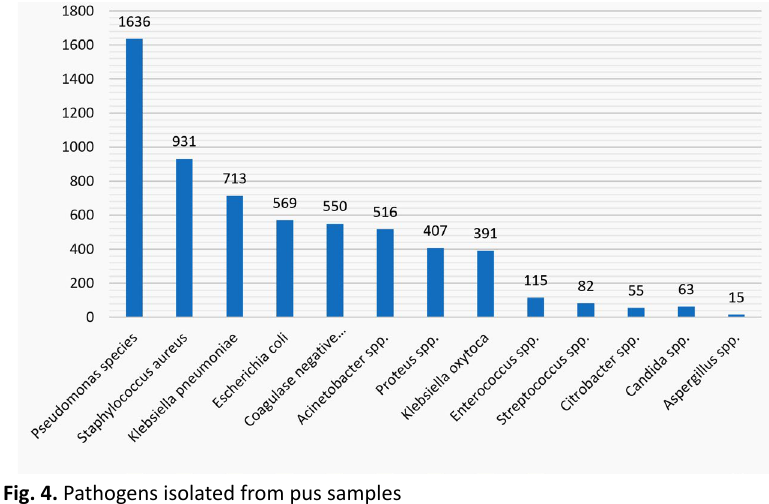
Fig. 4. Pathogens isolated from pus samples